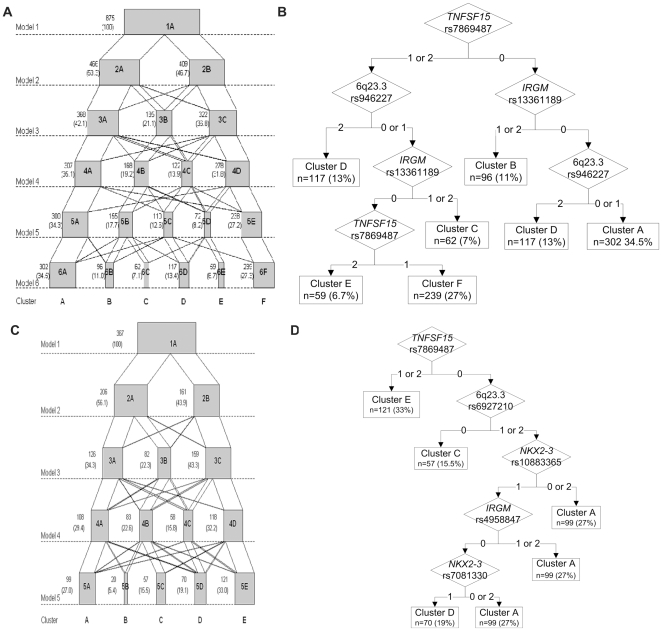
Modelbuilding process and classification trees for the final model.Formation of genetic-based subgroups when the number of clusters was increased stepwise for CD patients (panel A) or healthy controls (panel C) is shown. Data are presented as n (%). Box widths are proportional to the number of individuals in the respective cluster. The area of the white parallelograms connecting two clusters, one from Model i and one from Model i+1, is proportional to the number of individuals that are common between these clusters. Tree plot showing how SNPs determine the grouping of individuals into the different clusters for CD patients (panel B) and healthy controls (panel D). The diamond indicates where a decision is made (genotype 0 (wild-type), 1 (heterozygous) and/or 2 (homozygous mutant)). A rectangle indicates the decision (which cluster the patient belongs to when following the tree). The number and percentage of individuals in each cluster is presented as well.